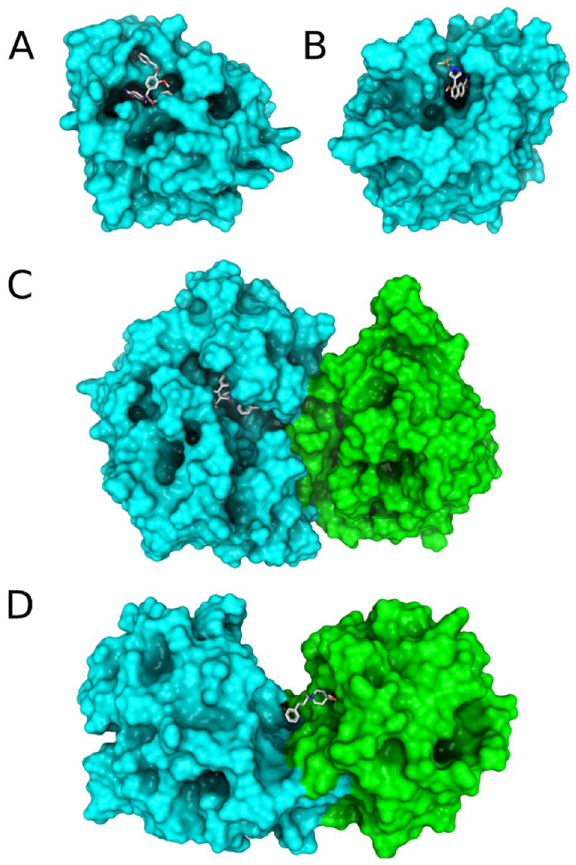
Figure 6. Surface representation of the binding sites of the proteases ( A ) FA7, ( B ) UROK, ( C ) RENI, and ( D ) TRYB1 colored by chain. The co-crystallized ligand is represented as sticks.